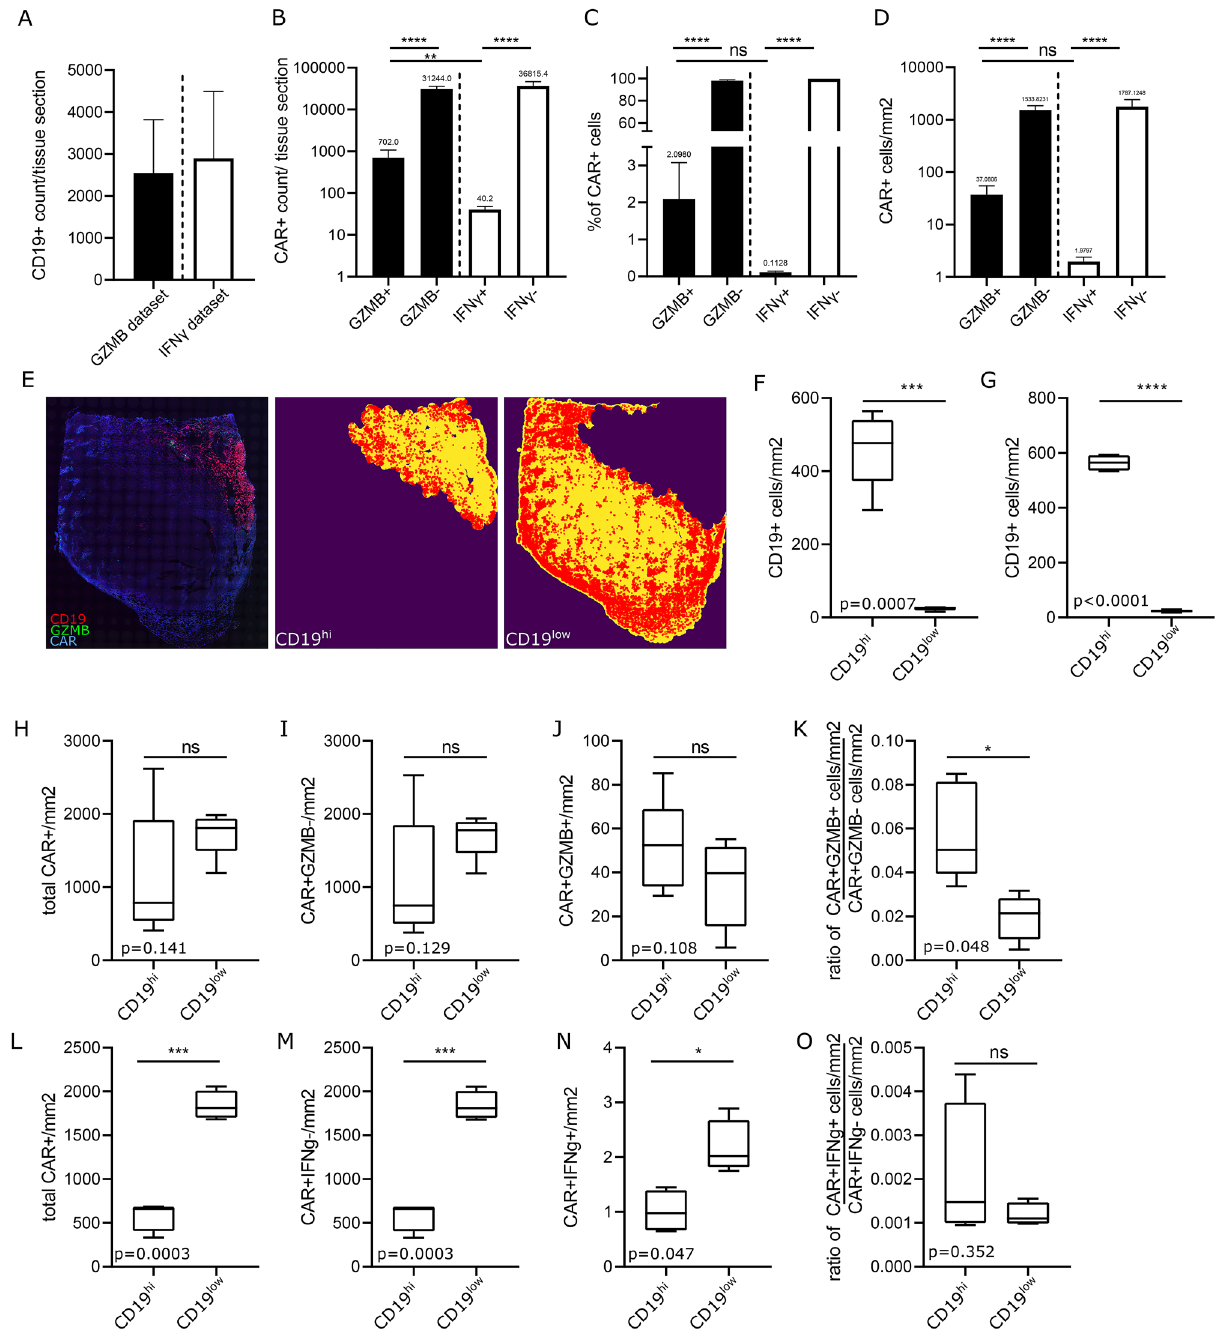
Figure 5. Spatial density analysis of the GZMB + and IFNγ + CAR T cells in CD19high and low areas reveals differential spatial effector gene expression. Statistics of the CD19/CAR/ GZMB (n = 5) and CD19/CAR/ IFNγ (n = 5) cumulative datasets from Fig. 4 and supplementary Fig. 8 and 9. Total CD19+ cells/mm2 ( A ) as well as total number ( B ), frequency ( C ) and spatial density ( D ) of CAR+ GZMB −, CAR+ GZMB + , CAR+ IFNγ −, CAR+ IFNγ + are shown. To assess the effect of CD19 antigen expression on CAR T cell function tumor sections were separated into a CD19high and CD19low areas and the number of CAR T cells that express GZMB and IFNγ or not within the two areas were counted. An example shows how tissue sections were separated in CD19high and CD19low areas denoted by the yellow color and, in this case the CAR+ GZMB − cells as red dots ( E ). Spatial density of CD19+ cells in the CD19high and CD19low area in the CD19/CAR/ GZMB (n = 5) ( F ) and CD19/CAR/ IFNγ (n = 4) ( G ) cumulative datasets. For the CD19/ CAR/ GZMB cumulative dataset, total CAR+ cells/mm2 ( H ), CAR+ GZMB − cells/mm 2 ( I ), CAR+ GZMB + cells/mm 2 ( J ), and the ratio of CAR+ GZMB + to CAR+ GZMB − cells/mm 2 ( K ) in the CD19high and CD19low area are shown. For the CD19/CAR/ IFNγ cumulative dataset, total CAR+ cells/mm 2 ( L ), CAR+ IFNγ − cells/mm 2 ( M ), CAR+ IFNγ + cells/mm 2 ( N ), and the ratio of CAR+ IFNγ + to CAR+ IFNγ − cells/mm2 ( O ) in the CD19high and CD19low area are shown. ( C,D ) were analyzed by one-way ANOVA. ( F-O ) were analyzed by paired t